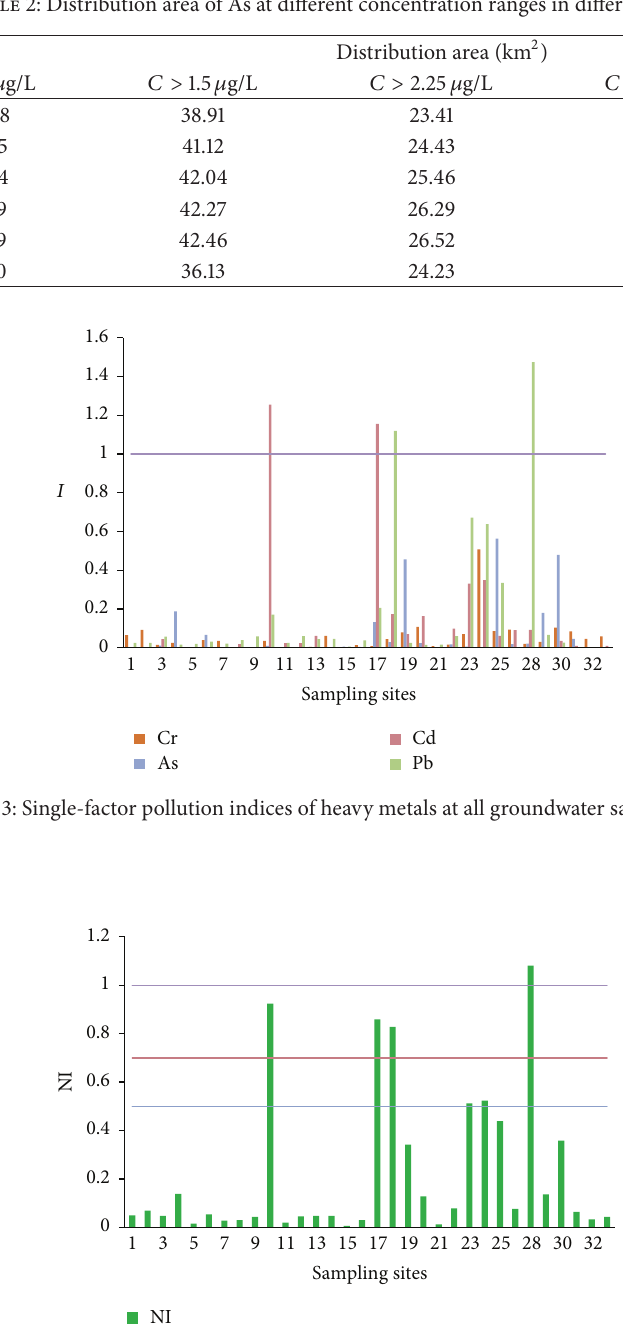
Table 2: Distribution area of As at different concentration ranges in different years.